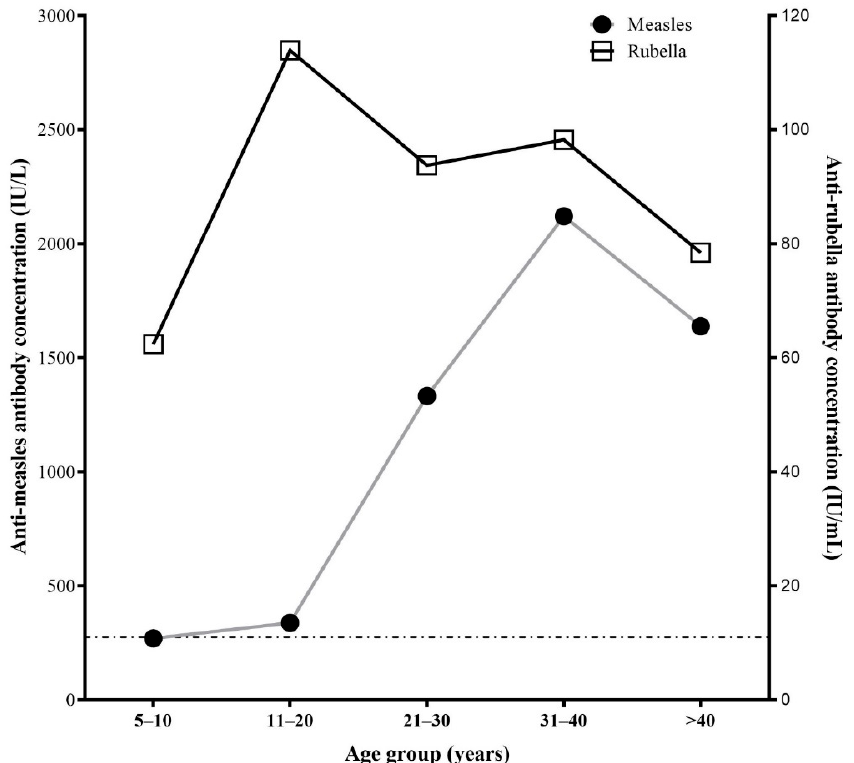
Figure 2. Age-stratified anti-measles and anti-rubella median antibody titers by age group. The horizontal dotted line represents the positivity cut-off for anti-measles (275 IU/L) and anti-rubella (11 IU/mL) antibodies.